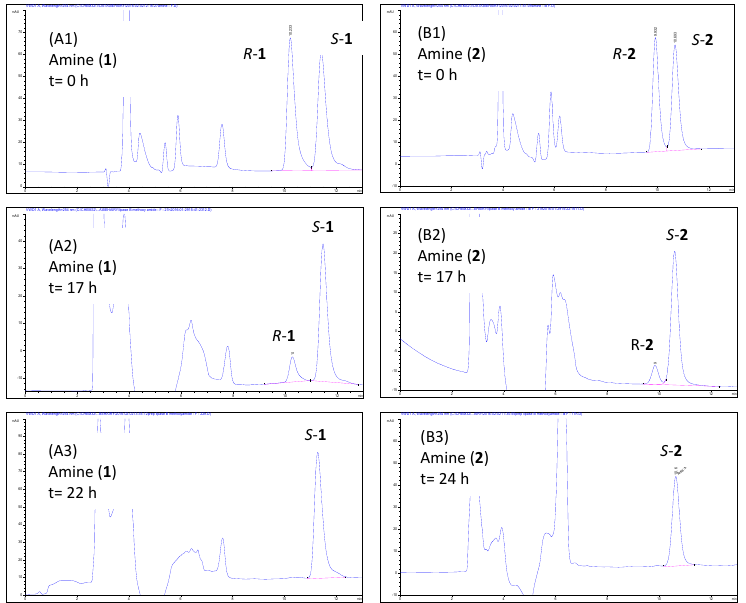
Figure 5. HPLC chromatograms of reaction progress of Cal-B enantioselective methoxyacetamidation of amines 1 and 2